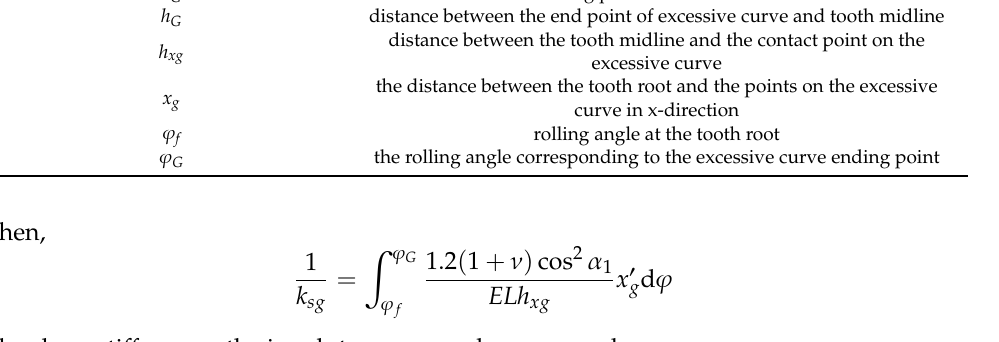
Table 2. Parameters for the transition part of the curve. Parameter The Main Meaning F the meshing force on the tooth curve F b the y-direction component of meshing F F a the x-direction component of meshing F I xg rotational inertia of gear on the excessive part curve d G distance between the ending point on the excessive curve and tooth root h G distance between the end point of excessive curve and tooth midline distance between the tooth midline and the contact point on the h xg excessive curve the distance between the tooth root and the points on the excessive x g curve in x-direction ϕ f rolling angle at the tooth root ϕ G the rolling angle corresponding to the excessive curve ending